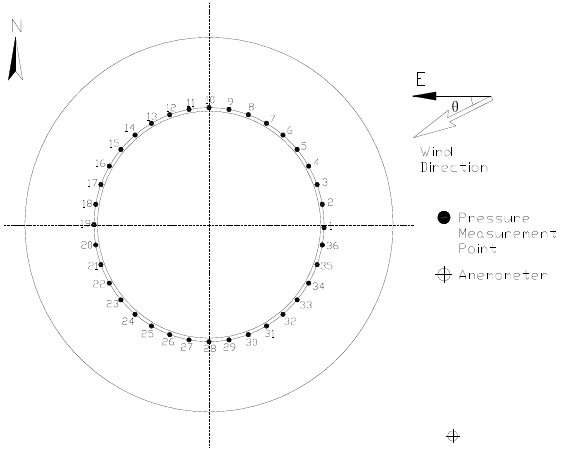
Figure 3. Plan of pressure measurement points.